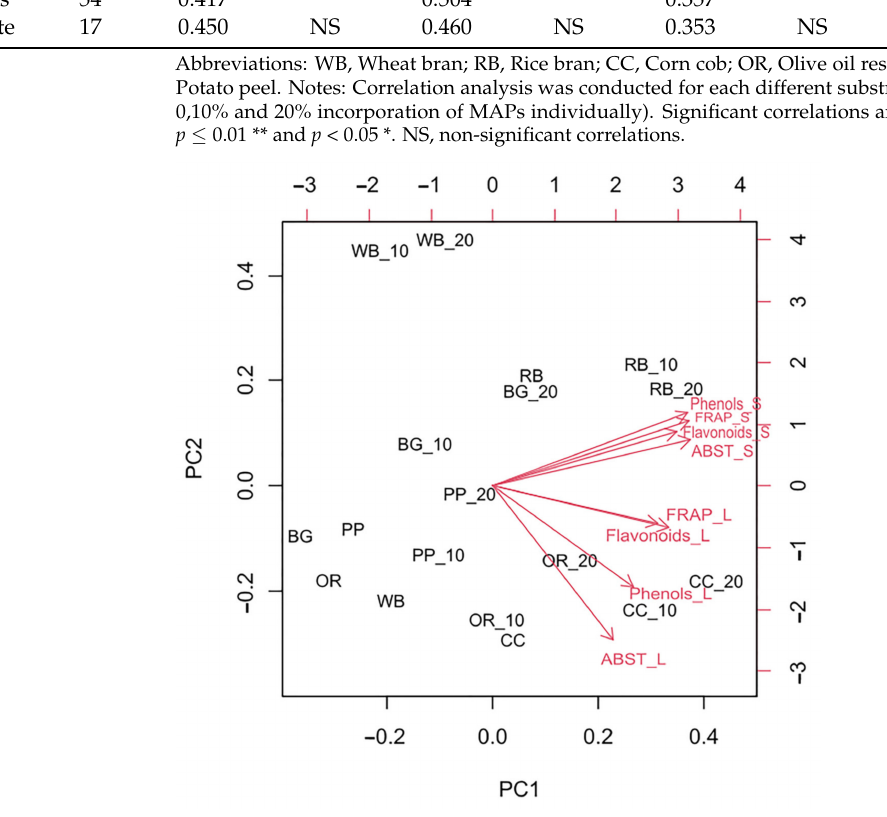
Figure 5. Principal Component Analysis (PCA) performed on total phenols and flavonoid content and antioxidant potential of substrates and Tenebrio molitor larvae reared on the respective substrates (WB, Wheat bran; RB, Rice bran; CC, Corn cob; OR, Olive oil residues; BR, Biogas residues; PP, Potato peel). Red vector arrows were included as predictors in the PCA